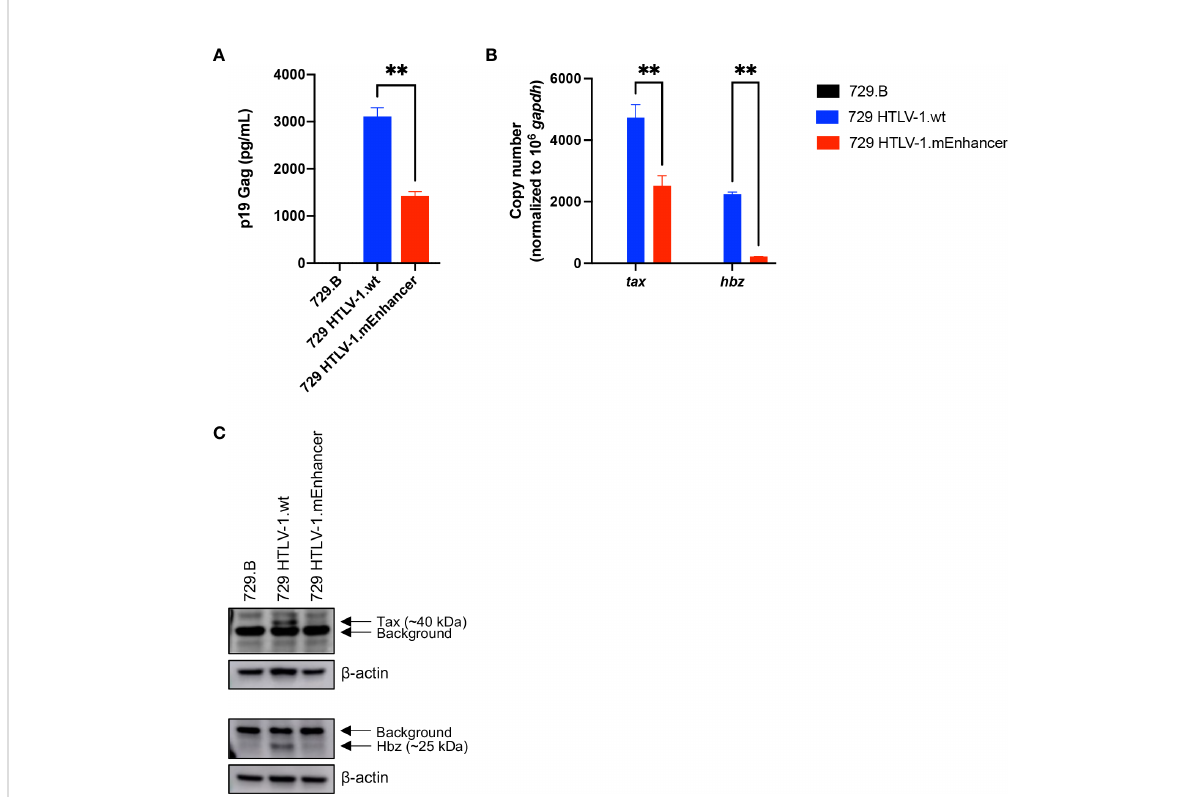
FIGURE 2 Generation and characterization of HTLV-1.mEnhancer producer cells. HTLV-1.wt and HTLV-1.mEnhancer producer cells were generated by nucleofecting 729.B parental cells with proviral plasmid DNA. After G418 selection and limiting dilution, (A) supernatant was collected from single cell clones for p19 Gag ELISA. Only one clone with suf fi cient virion production compared to HTLV-1.wt was selected for additional experiments and analyses. Statistical signi fi cance was determined by unpaired t test. **P ≤ 0.01. (B) RNA was extracted from the HTLV- 1.mEnhancer clone for cDNA synthesis and qPCR to detect tax and hbz mRNA expression. Statistical signi fi cance was determined by